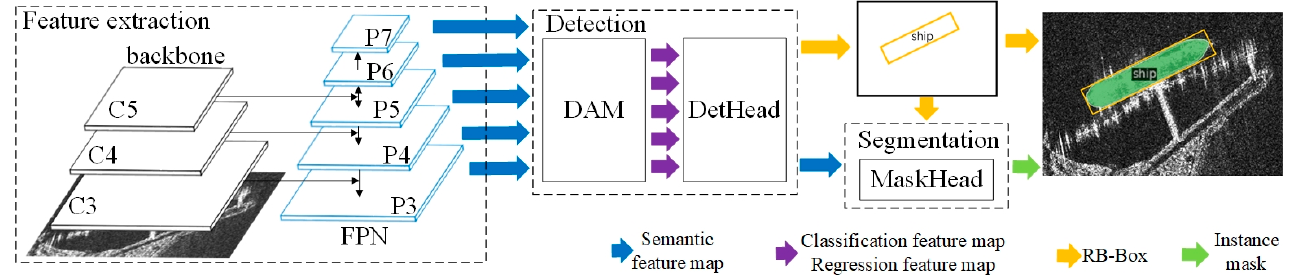
Figure 2. Overview of the proposed SRNet, consisting of a feature extraction procedure, a detection procedure, and a segmentation procedure. In the feature extraction procedure, the FPN takes feature maps C3, C4, and C5 extracted by the backbone as inputs and then outputs semantic feature maps P3–P7. In the detection procedure, these semantic feature maps are first transmitted to the DAM to produce the classification feature maps and regression feature maps. Then the DetHead takes the outputs of DAM as inputs to output the RB-Boxes and their classification scores. The segmentation procedure takes the RB-Boxes and the semantic feature maps as inputs and then outputs the final instance masks.